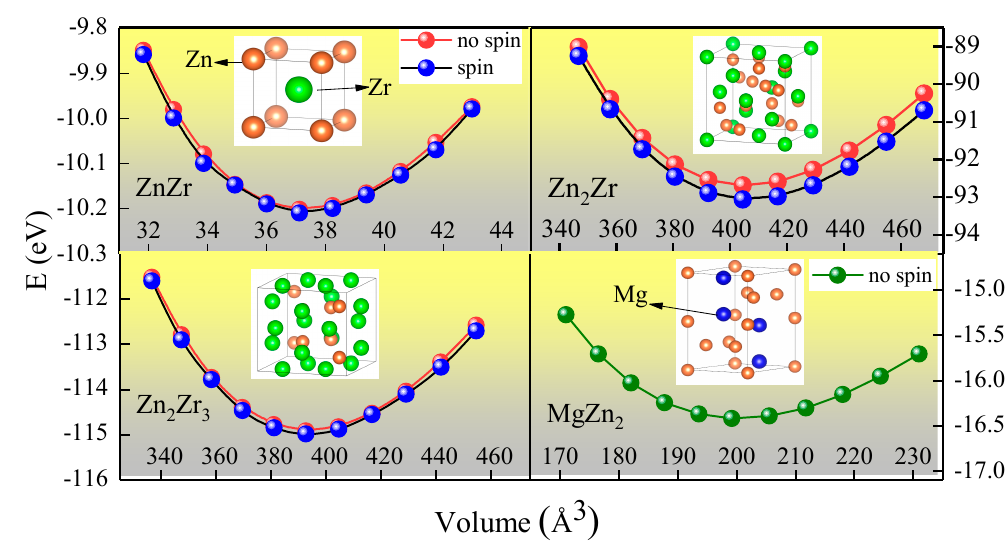
Figure 1. Total energy as a function of unit cell volume for ZnZr, Zn 2 Zr, and Zn 2 Zr 3 at both no-spin and spin states, as well as MgZn 2 at the nonmagnetic state.